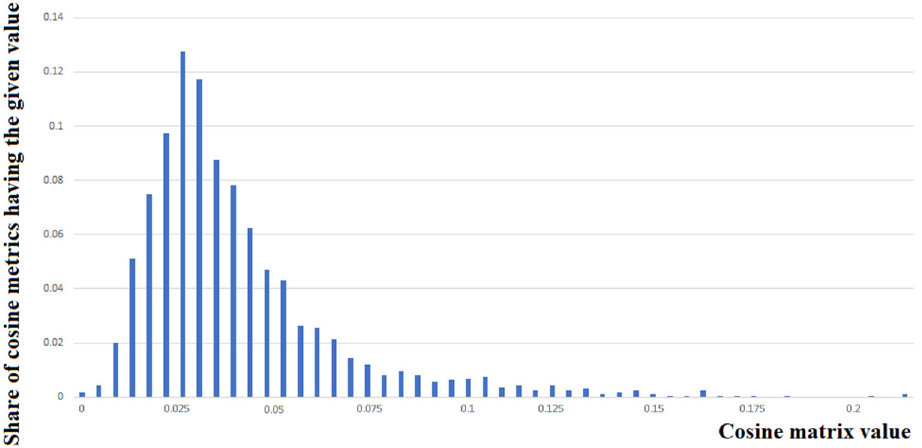
Figure 7. Graphical representation of the distribution of cosine metric values in the first row of the lexico ‐ semantic bond matrix for the text corpus used in this study.